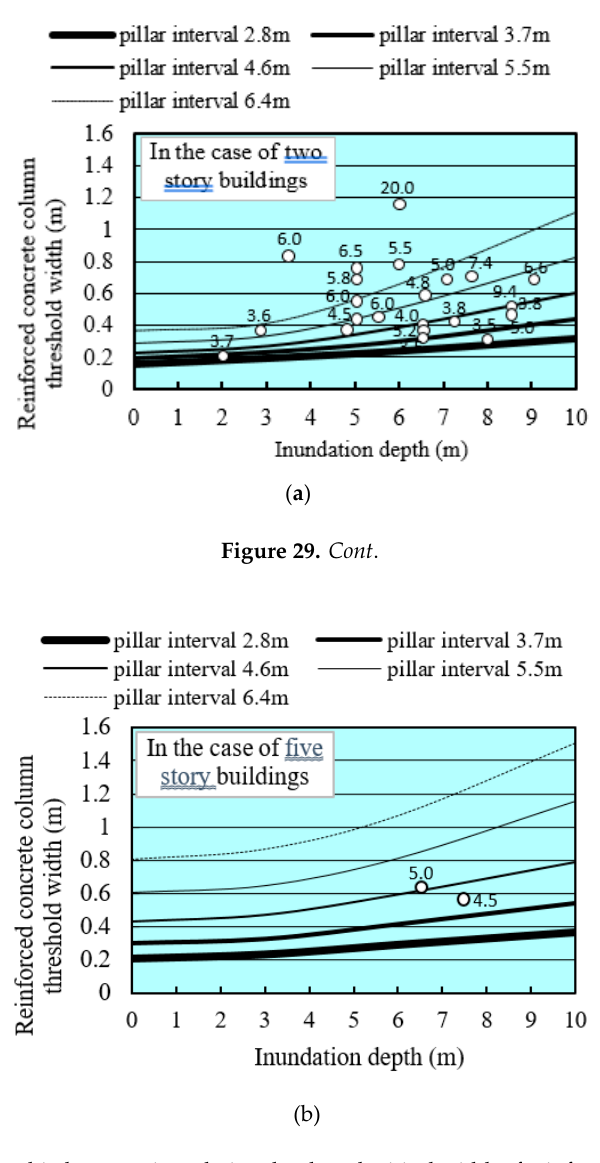
Figure 29. ( a ) Relationship between inundation depth and critical width of reinforced concrete columns (the numbers in the figure are the pillar intervals). ( b ) Relationship between inundation depth and critical width of reinforced concrete columns (the numbers in the figure are the pillar intervals).